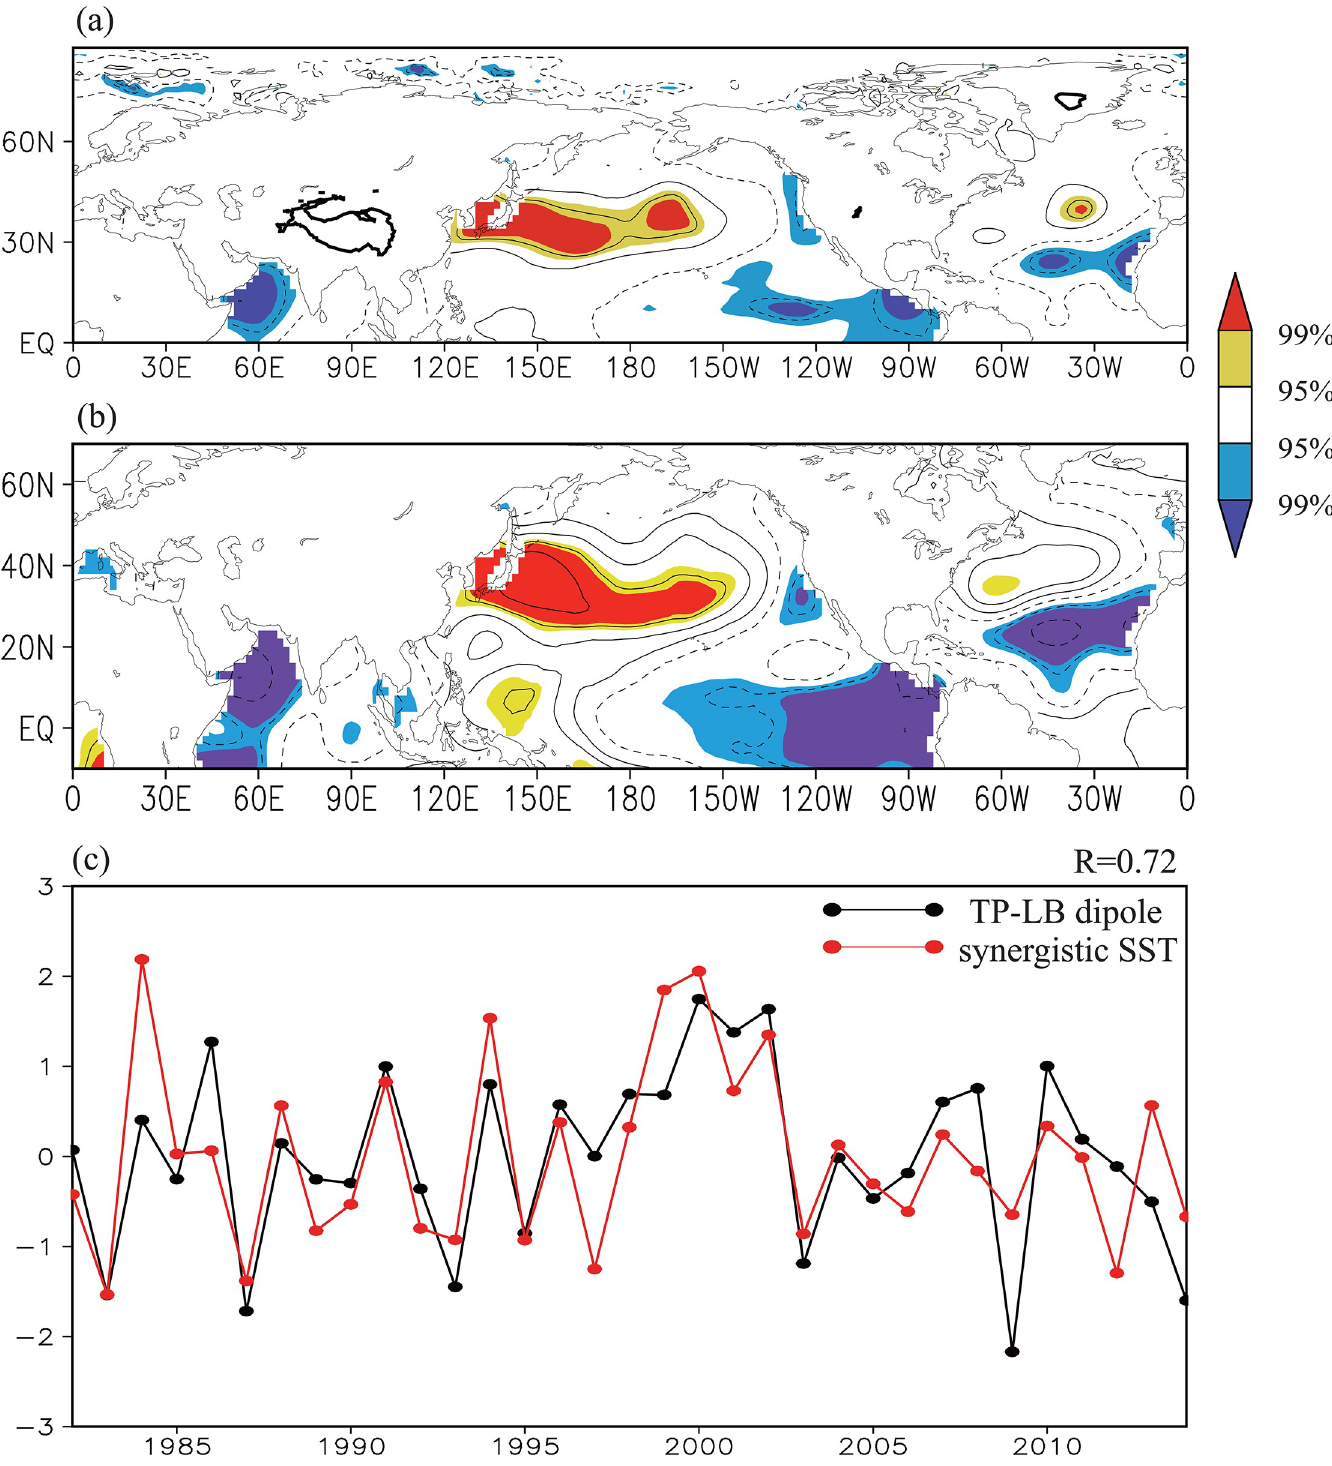
Fig 9. (a) Distribution of the correlation coefficients between the Tibetan Plateau–Lake Baikal dipole index and the simultaneous SST field during the time period 1982–2014. (b) as in (a), but for that between the synergistic SST index and the SST field. The solid contour denotes areas higher than 3000 m altitude. The yellow (red) shading denotes a positive correlation significant at the 95% (99%) confidence level and the blue (purple) shading negative correlation significant at the 95% (99%) confidence level. (c) Time series of the normalized Tibetan Plateau–Lake Baikal dipole (black line) and synergistic SST (red line) indices during the time period 1982– 2014. TP–LB, Tibetan Plateau–Lake